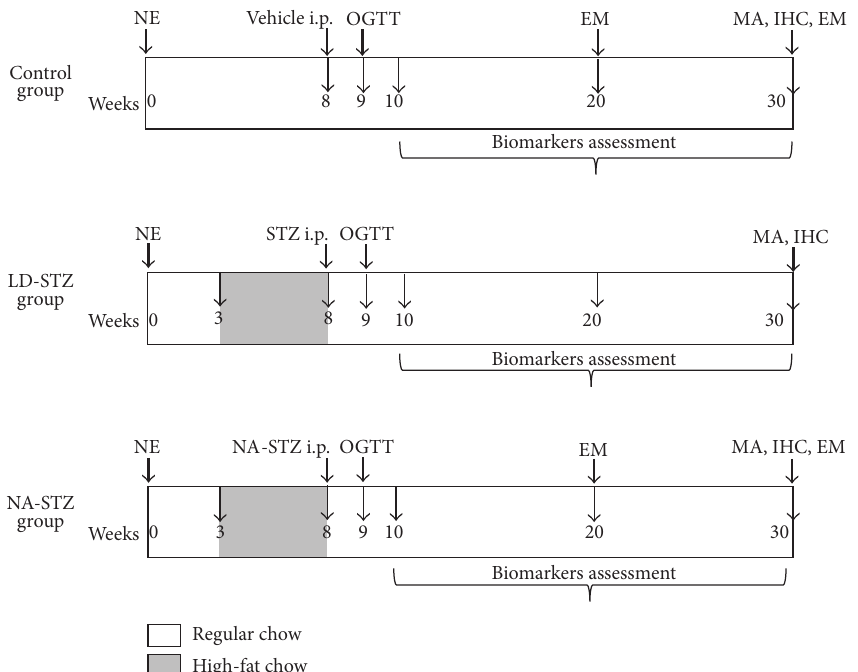
Figure 1: Schematic diagram of the experimental protocol. NE: right-side nephrectomy; STZ: streptozotocin; NA: nicotinamide; MA: light microscopy and morphometric analysis; IHC: immunohistochemistry; EM: electron microscopy; i.p.: intraperitoneally; OGTT: oral glucose tolerance test. NA-STZ group: uninephrectomized rats received the high-fat diet containing beef tallow for 5 weeks (from week 3 till week 8), and then successive intraperitoneal injections of NA (230mg/kg) and STZ (65 mg/kg) in 15 min interval were administered. LD-STZ group: uninephrectomized rats received the same high-fat diet at the same period of the experiment, and then intraperitoneal injection of STZ in a lower dose (40mg/kg) was administered. Control group: uninephrectomized rats received the regular commercial rodent chow during the experiment and received vehicle instead of